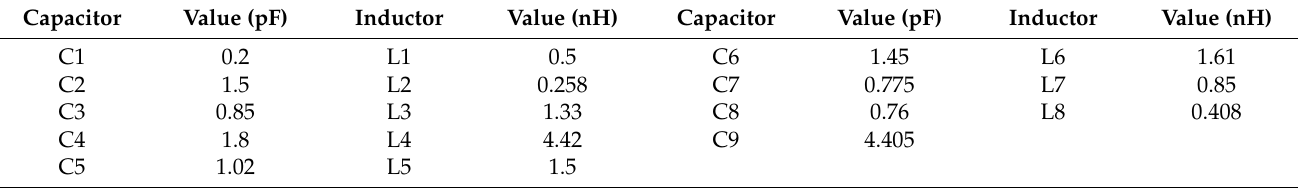
Figure 6. ( a ) Equivalent circuit model of metamaterial unit cell and ( b ) transmission coefficients S21 from CST and ADS simulator. Table 3. Circuit components and values of the